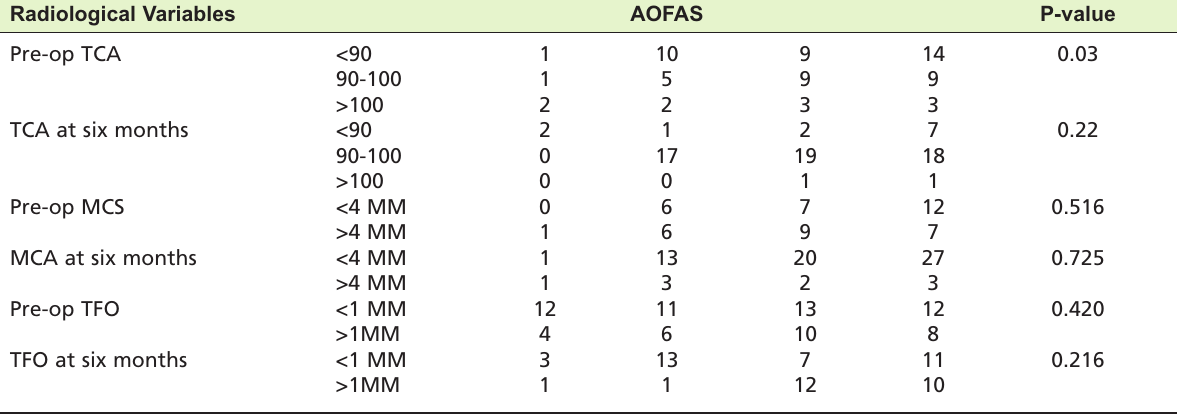
Table showing the various radiological parameters that influence the AOFAS Table III: